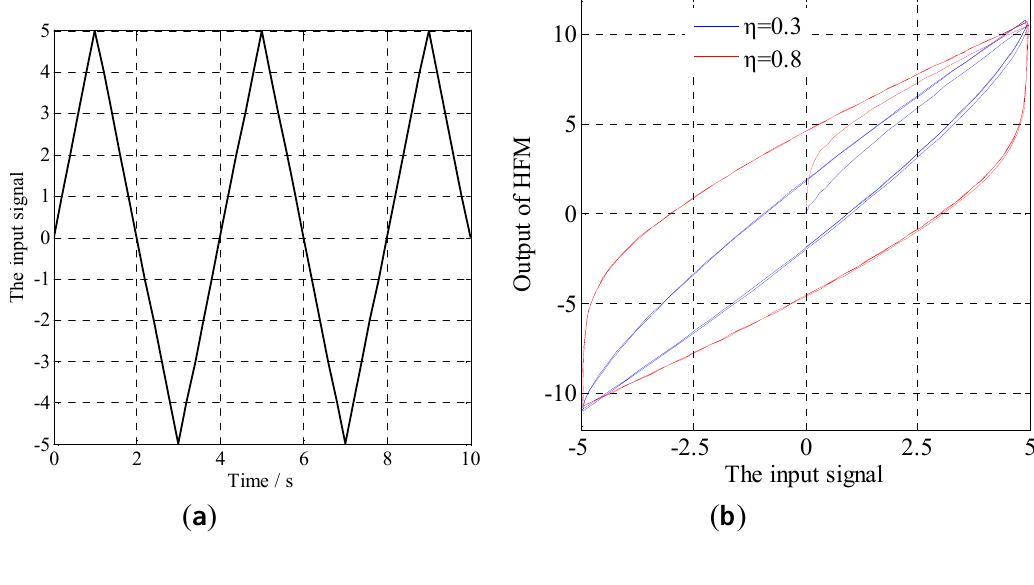
Figure 4. Characteristics of the HFM: ( a ) The input signal; ( b ) The relationship between the input and the